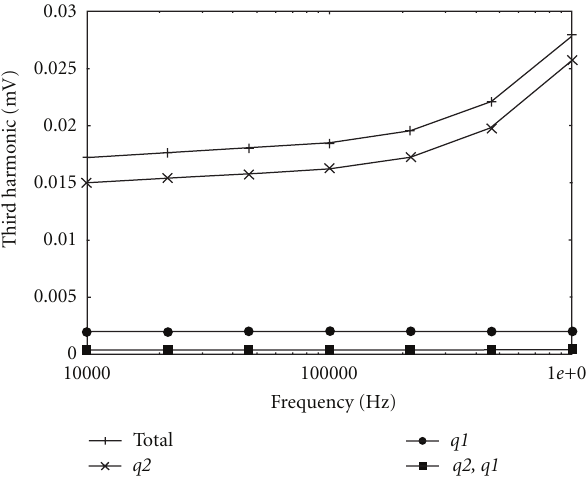
Figure 6: Third harmonic and its